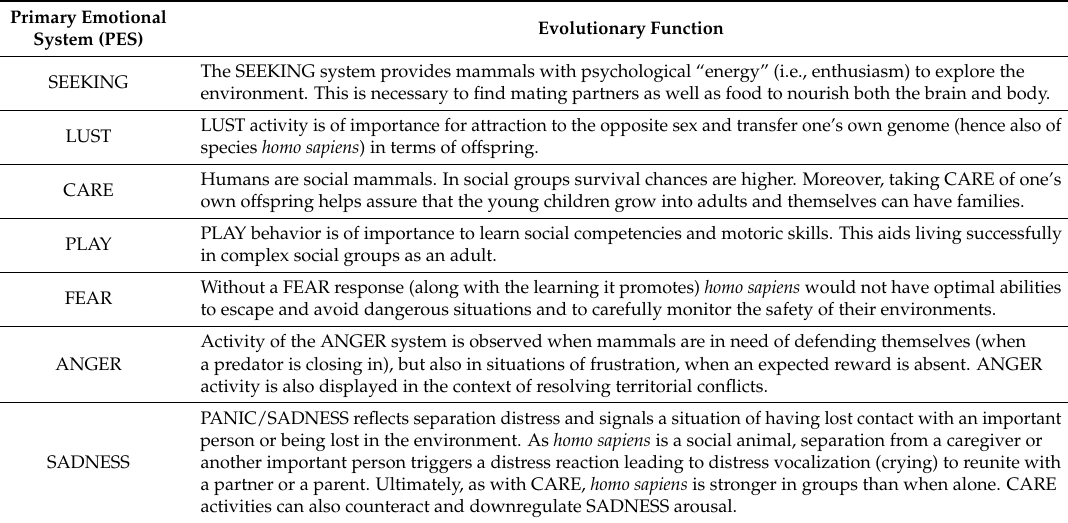
Table 1. Primary emotional systems represent in-built tools for survival that are highly conserved across the mammalian brain (taken from Montag & Panksepp, 2017; see [21]). Primary Emotional System